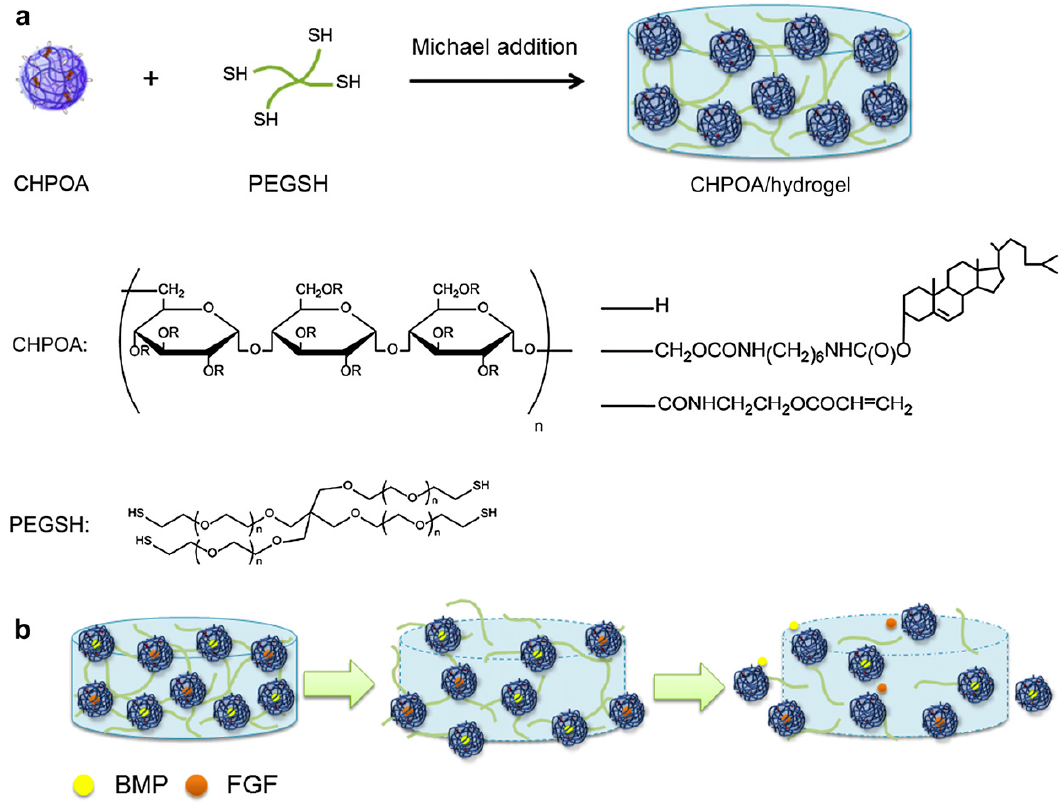
Figure 10. Cholesterol-bearing pullulan biodegradable nanogels for bone morphogenetic protein 2 (BMP2) and fibroblast growth factor 18 (FGF18) delivery for bone regeneration. ( a ) Synthesis of the acryloyl-group-bearing CHP (CHPOA) / hydrogel block and CHPOA nanogel and the chemical structure of pentaerythritol tetra (mercaptoethyl) polyoxyethylene (PEGSH). (‘R’ in CHPOA is H (glucose), cholesterol, and acryloyl). ( b ) Schematic diagram shows the release of FGF18 and BMP2 from cholesterol-bearing pullulan nanogels (green arrow represents the protein exchange reaction of serum albumin with FGF18 and BMP2). Adapted from Ref. [197] reproduced by permission of The Elsevier.